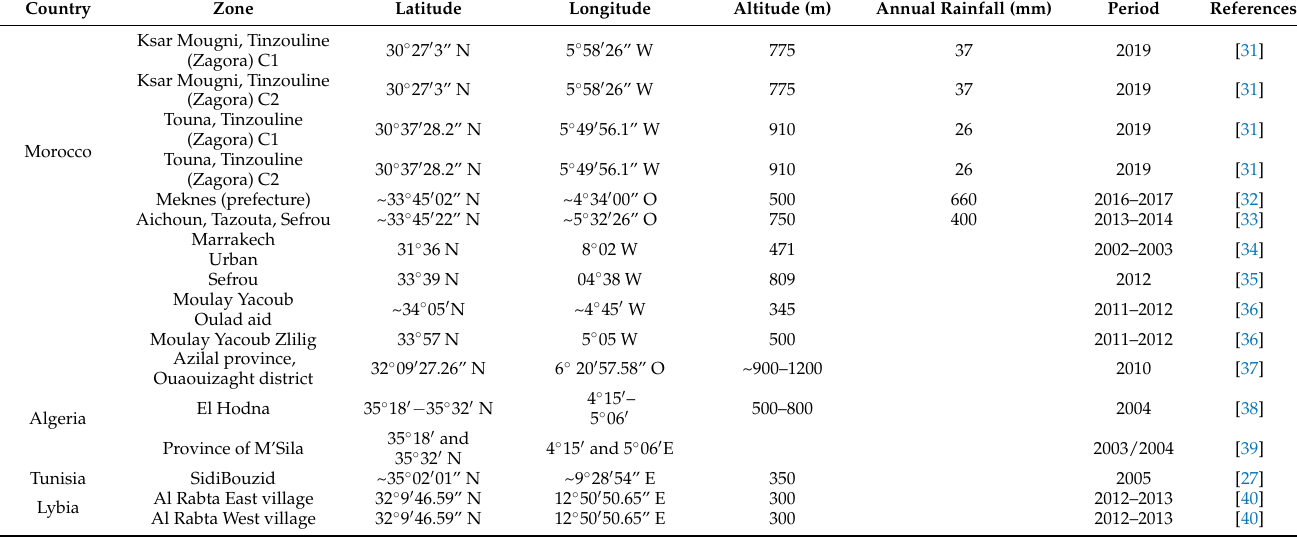
Table 2. Geolocalization of sites whose monthly density data of P. papatasi in the North African countries was extracted. The geographic information includes the latitude, longitude, and altitude (m); for the sites without geographic data, the symbol ‘~’ was used, and the approximate values were estimated from Google